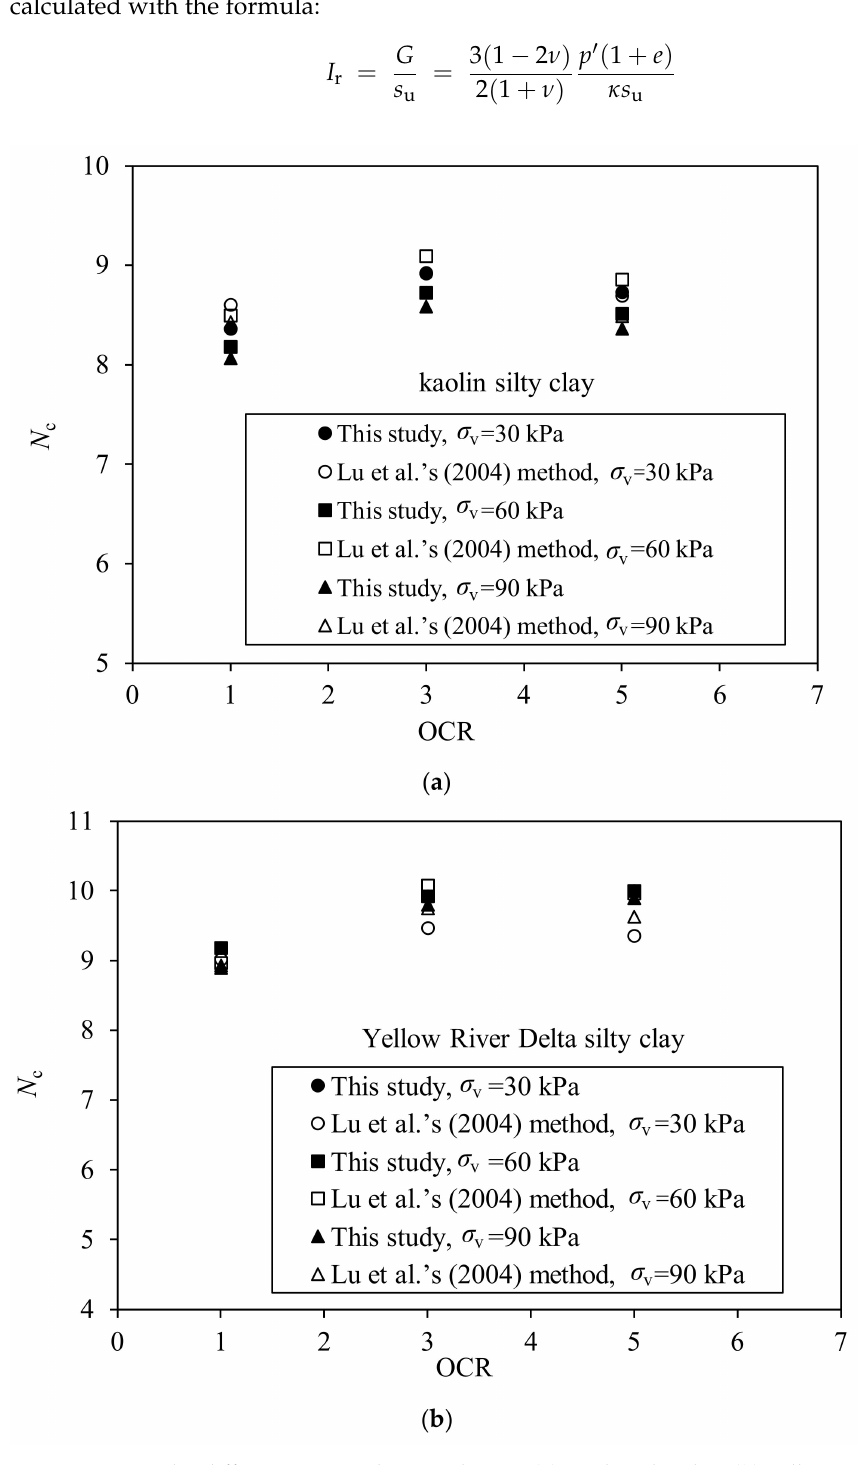
Figure 5. N c under different OCR and σ v conditions. ( a ) Kaolin silty clay; ( b ) Yellow River delta silty clay